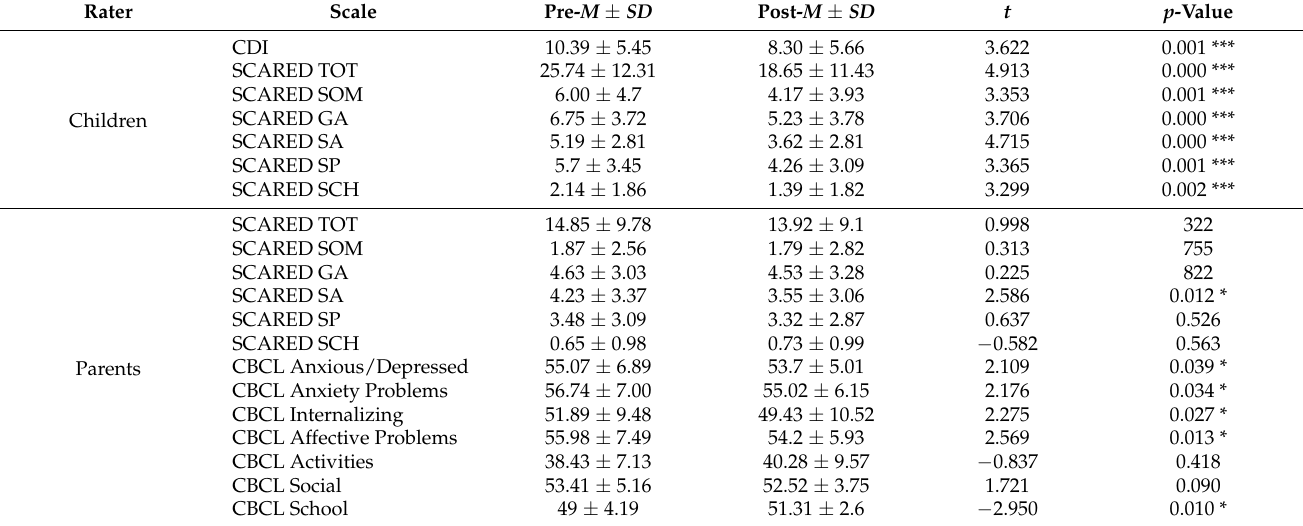
Table 2. Means, standard deviations and paired t -test results of Child Depression Inventory (CDI), Screen for Child Anxiety-Related Emotional Disorders (SCARED) and Child Behavior Checklist/6-18 (CBCL) for children and